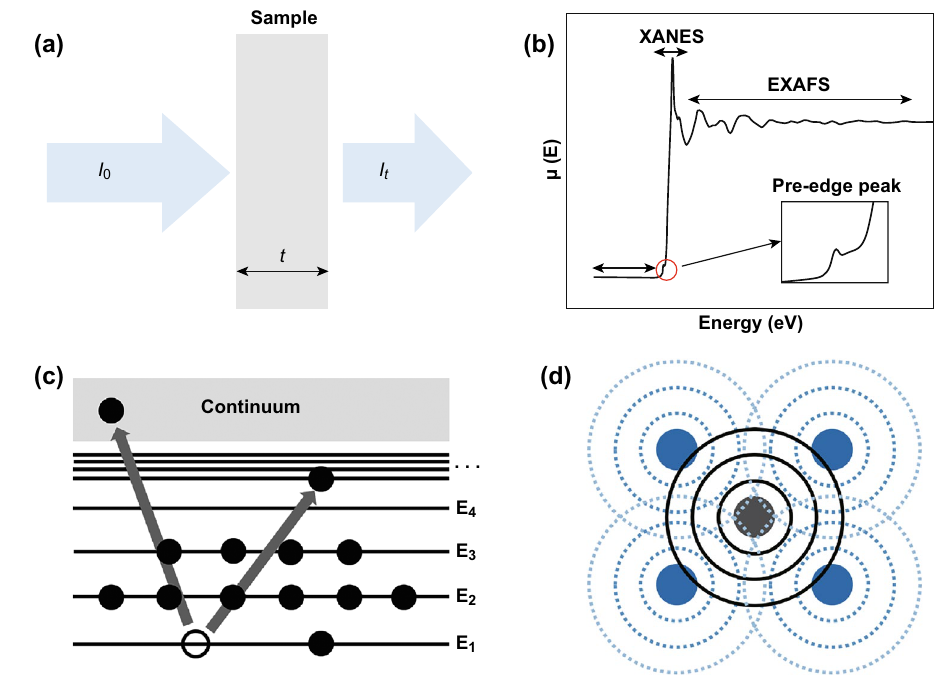
Fig. 1 a Schematic of incident and transmitted X-ray beam. b Schematic of XAS including the pre-edge, XANES, and EXAFS regions. c Sche- matic of the X-ray absorption process and electron excited process, the black circle is electrons. d Schematic of interference pattern creating by the outgoing (solid black lines) and reflected (dashed blue lines) photoelectron waves between absorbing atom (gray) and its nearest atoms (pur- ple). (Color figure